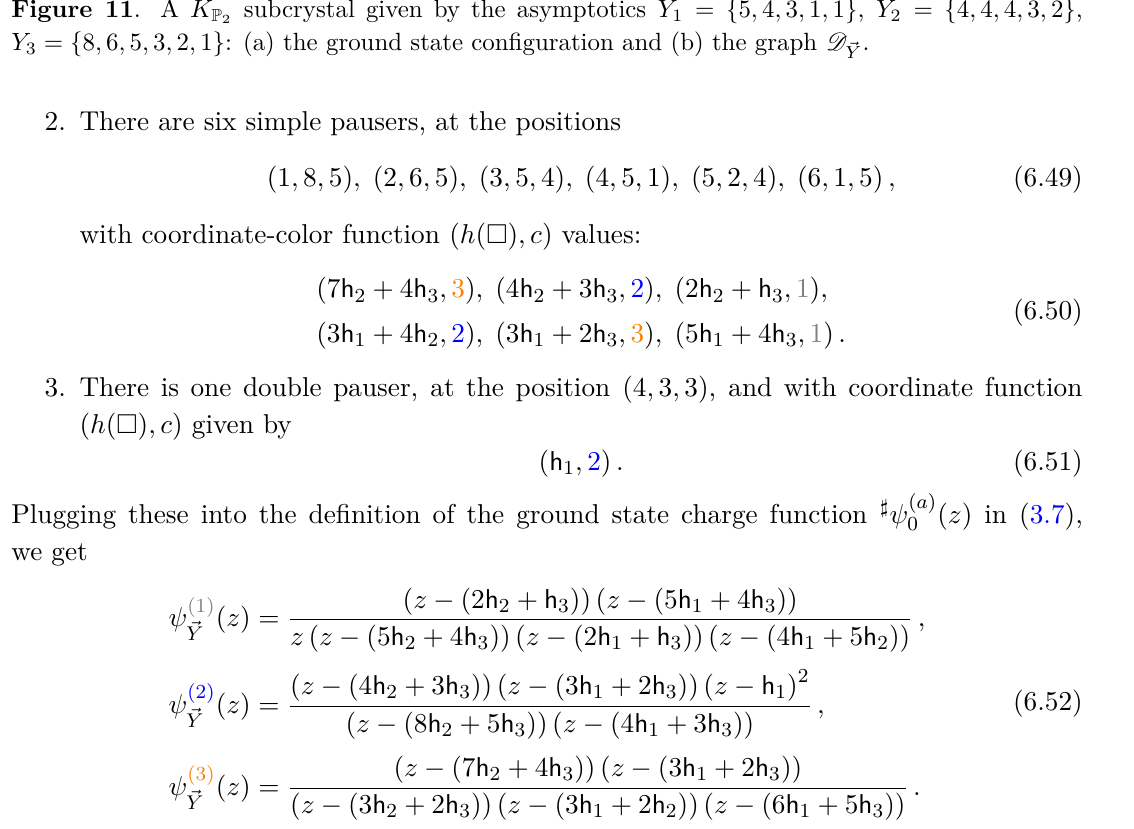
= { 5 , 4 , 3 , 1 , 1 } , Y = { 4 , 4 , 4 , 3 , 2 } , 1 2 Y